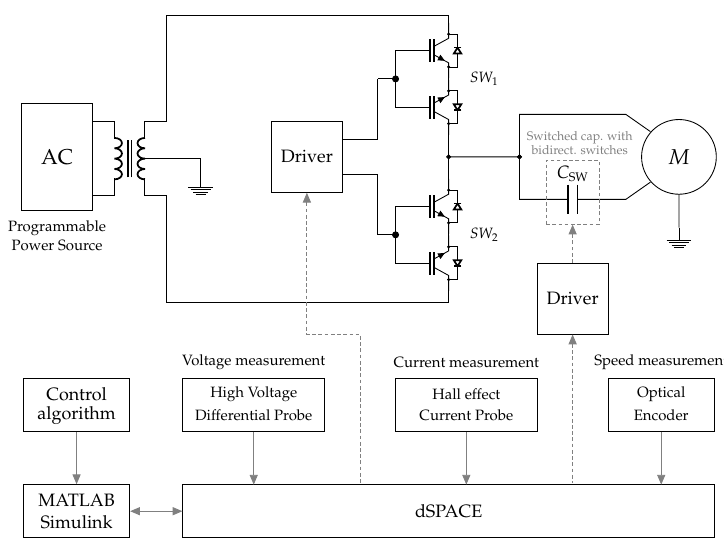
Figure 23. Experimental verification and measurement of the matrix converter with dSPACE hardware.